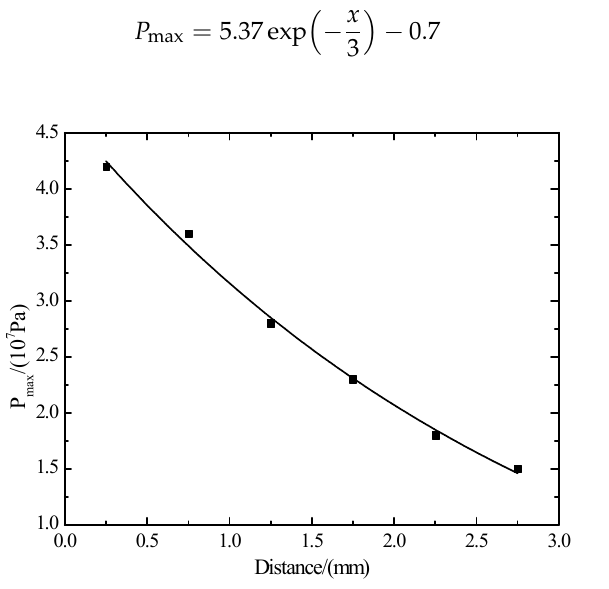
Figure 15. The attenuation rule of shock wave pressure in polysilicon.